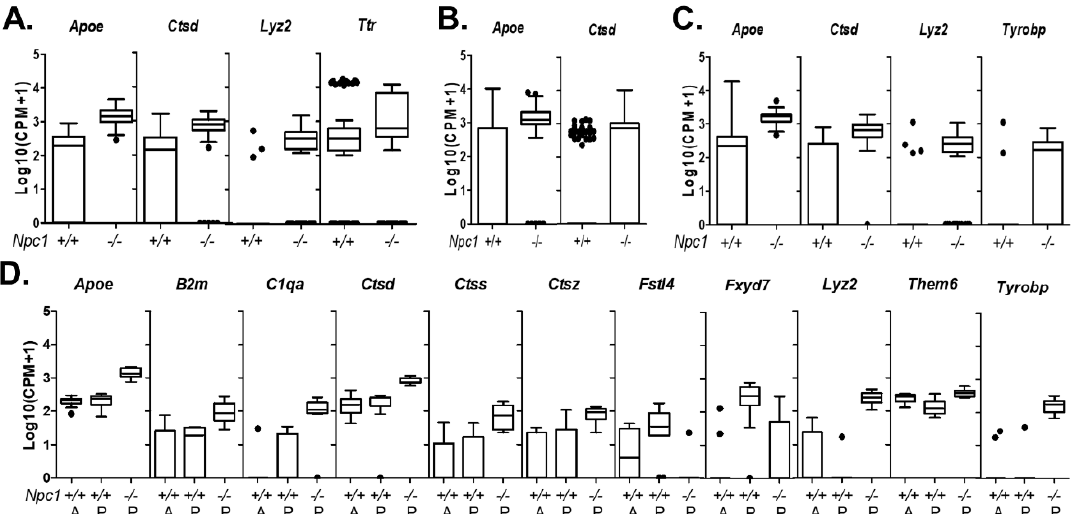
Figure 5. Differentially expressed genes in neuronal cells. Tukey box plots of differentially expressed genes in basket/stellate neurons ( A ), granule neurons ( B ), unipolar brush cells ( C ), and Purkinje neurons ( D ). In control cerebellum, anterior ( A ) and posterior ( B ) Purkinje neurons could be differentiated. In Npc1 −/− cerebellum from seven-week-old mice, only posterior Purkinje neurons were